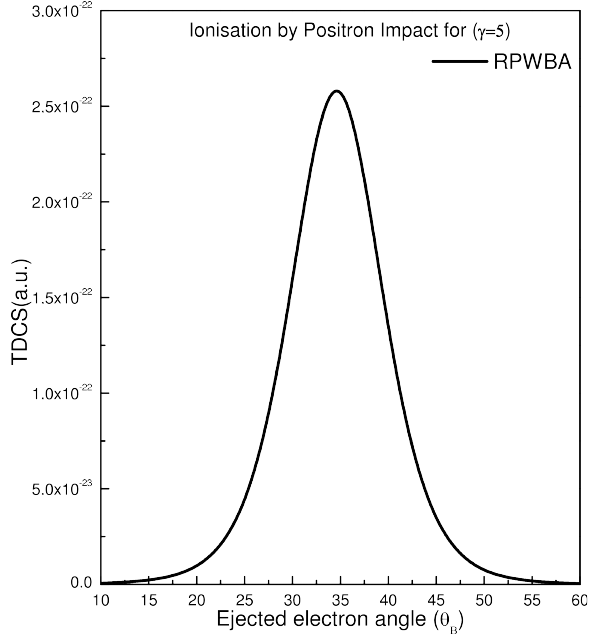
Figure 4. Same as in Figure 1 but for T i = 2043.996 keV and T B = 1021.9975